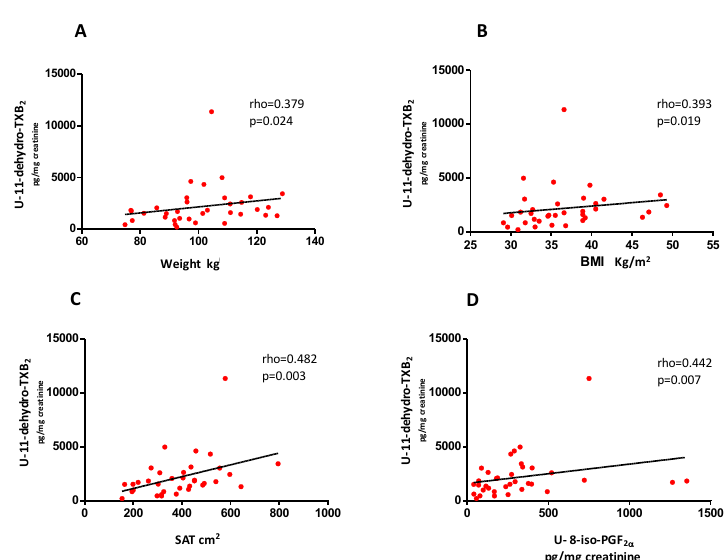
Figure 3. Baseline correlations between platelet activation and weight, body mass index (BMI), subcutaneous adipose tissue area, and lipid peroxidation. Basal correlation between U-11-dehydro- TXB 2 and weight (panel A ), BMI (panel B ), SAT (panel C ), and U-8-iso-PGF 2 α (panel D ) in obese patients with prediabetes or early diabetes. SAT, subcutaneous adipose tissue.